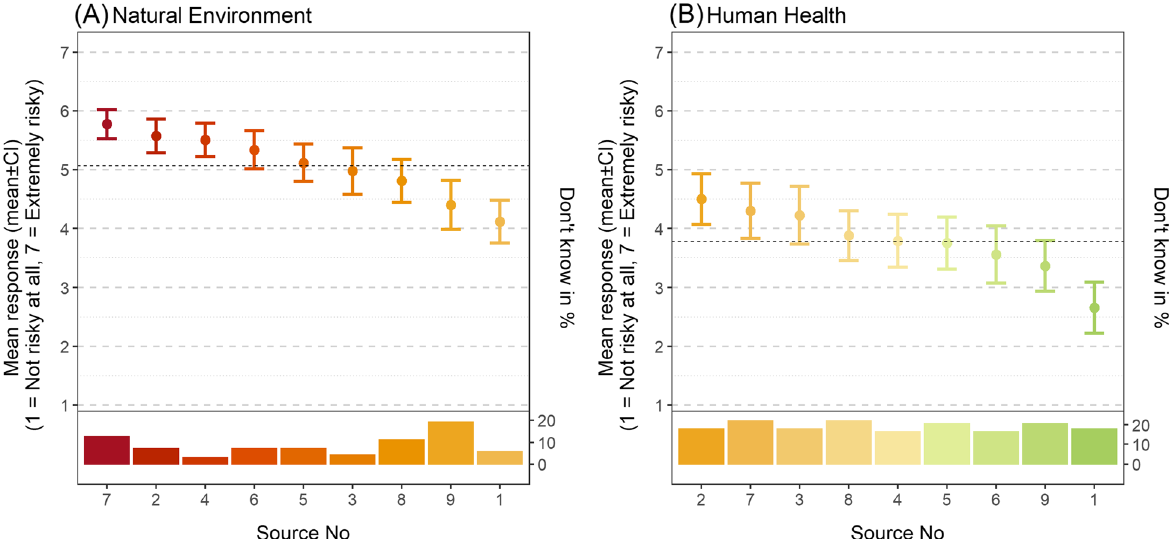
Fig. 2 Mean level of risk (with 95% CI), overall mean (indicated as dotted line) and don’t knows in percentage (separated by solid line) for (A) the natural environment and (B) human health across nine different microplastics sources displayed from highest to lowest rating. Microplastics sources: (1) Pre-production plastic pellets; (2) Textiles (e.g. microfiber); (3) Cosmetics, detergents, and cleaners (e.g. microbeads); (4) Disintegrated parts of larger consumer products (e.g. single use food & drink packaging etc.); (5) Fragments and pieces from industry and construction (e.g. paints); (6) Fragments and pieces from agriculture, aquaculture, fishing; (7) Tyre abrasion; (8) Synthetic/artificial surfaces in recreational sports and children’s playgrounds; (9) Biodegradable plastic